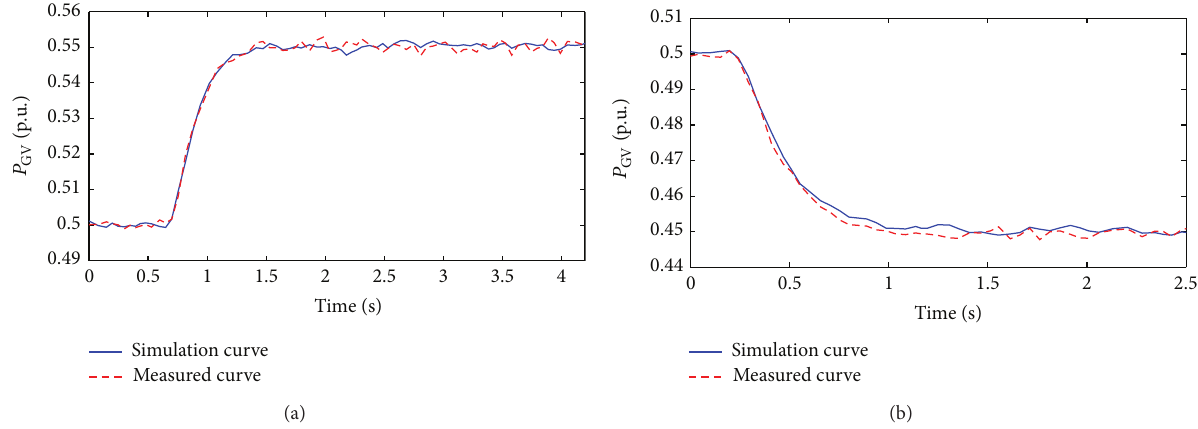
Figure 8: Valve opening simulation compared with the measured curve.